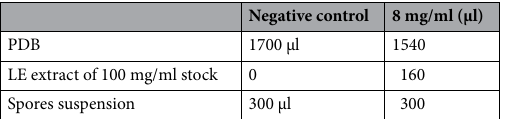
Table 8. Pre-setting of germination tubes used in SEM